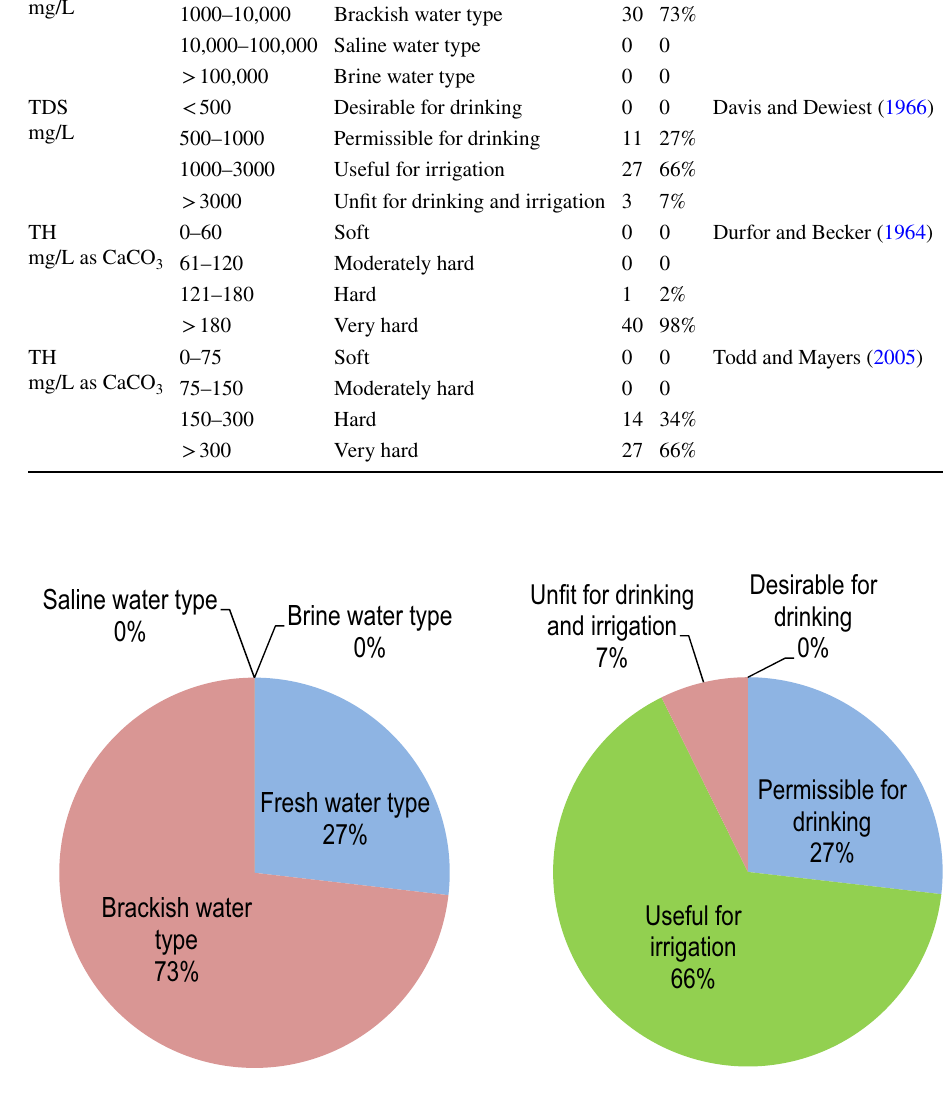
groundwater samples in the study area based on TDS and TH